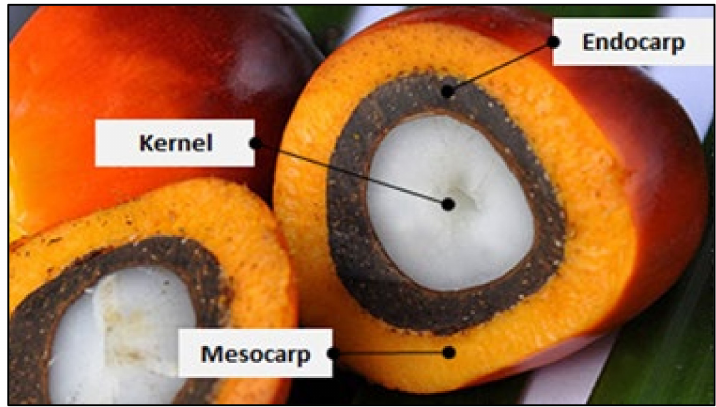
Figure 1. The characteristics of individual oil palm fruitlets (Vijaya et al., 2009)